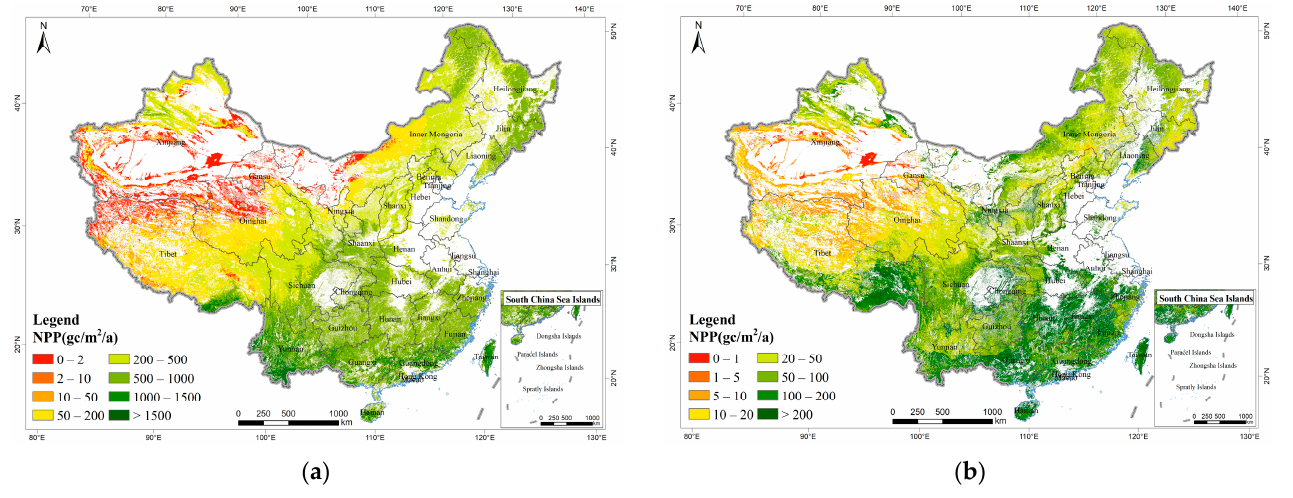
Figure 10. Restoration status ( a ) and restoration potential ( b ) of NPP in China’s forest, grassland and desert ecosystems. Table 8. Classification statistics of the restoration status and restoration potential of NPP in China’s forest, grassland and desert